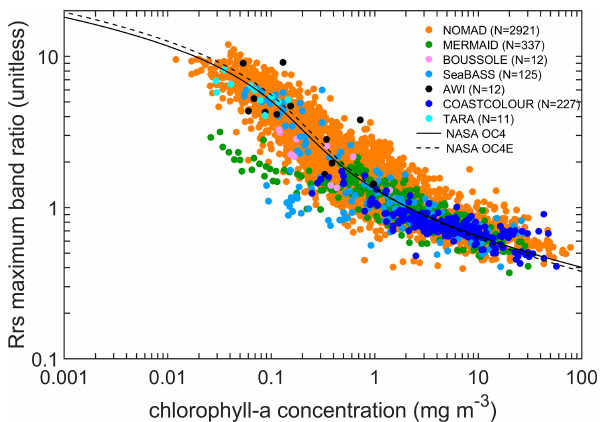
Figure 11. A remote-sensing reflectance maximum band ratio (as defined in text) ([443,490,510]/555 or [443,490,510]/560 if 555 not available) as a function of chlorophyll- a concentration. All chlorophyll data were considered, but for a given station, HPLC data were selected if available. Data within 2nm of the wave- lengths were used. For reference, the solid and dotted lines show the NASA OC4 and OC4E v6 standard algorithms, respectively (https://oceancolor.gsfc.nasa.gov/atbd/chlor_a/, last access: 18 De- cember 2022). The total number of points was 3645, of which 80% were from